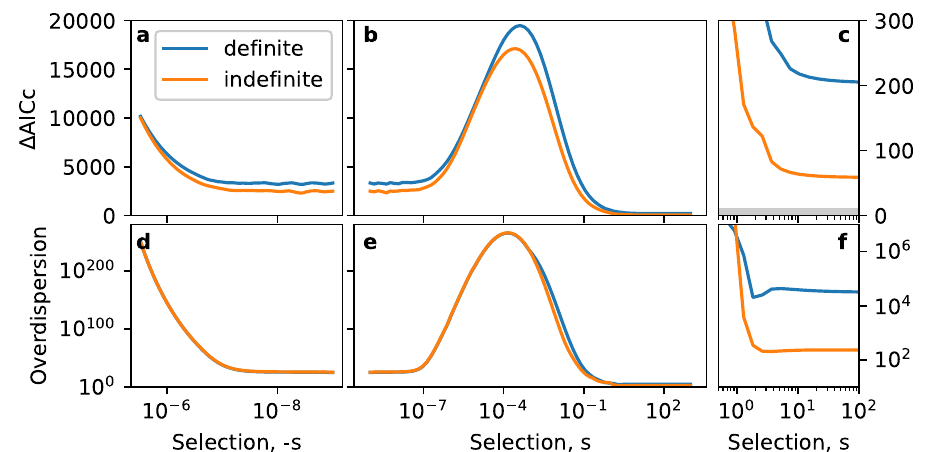
Fig 5. Δ AIC c (panels a–c) and binary overdispersion (c–f) for negative (a and d) and positive (b, c, d and f) selection strength s within a child-based learning paradigm. The smallest values of both measures (which indicate better fits to the data) are obtained for strong positive selection ( s > 1, highlighted in panels c and f which has a larger vertical scale). The Δ AIC values are far away from the shaded zone where Δ AIC � 10 and the evidence in favour of the child- c c based model starts to become comparable with that of the baseline.